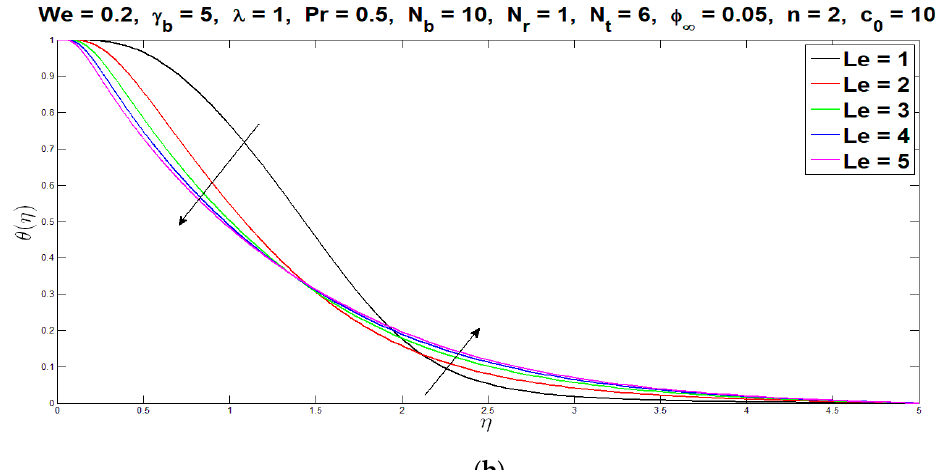
Figure 5. ( a ) Impact of 𝑃𝑟 over 𝜃 . ( b ) Impact of 𝑃𝑟 over 𝜃.